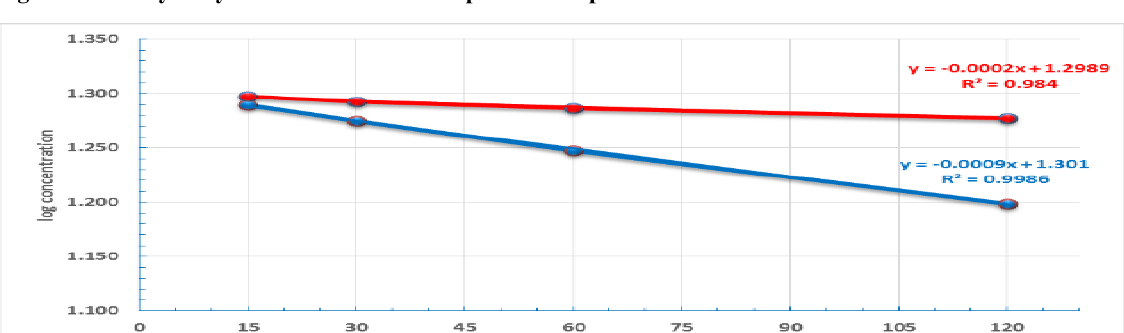
Figure 3. The hydrolysis rate of Mutual І at pH 1.2 and pH 7.4